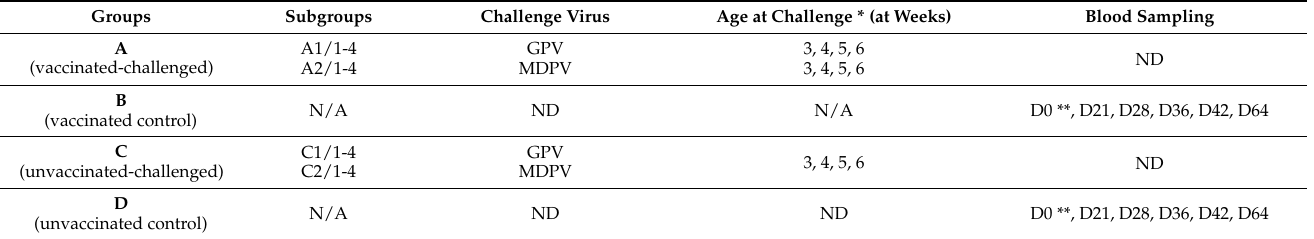
Table 3. Study design to evaluate the immunogenicity of the bivalent vaccine in MDA-positive Muscovy